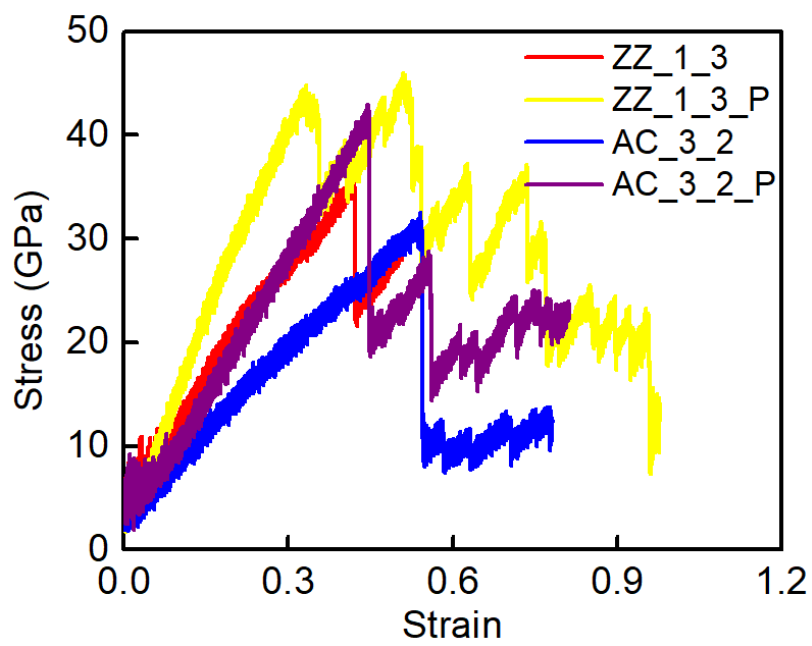
Figure 8. The stress-strain curves of Samples ZZ_1_3 and AC_3_2 under shear loading in both directions parallel and perpendicular to incisions on the GK membranes.